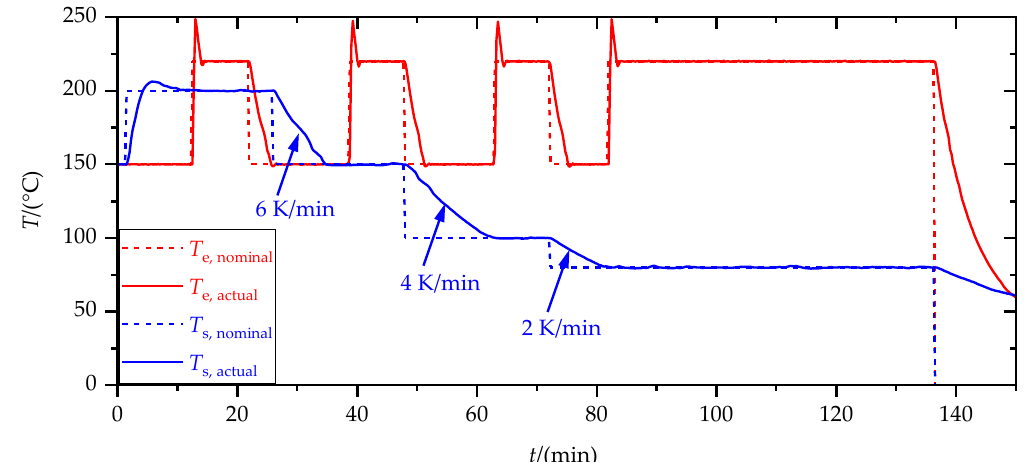
Figure 5. Temperature time profile of the nominal and actual temperature of the extruder, T e , and the substrate, T s , during production of an SLJ specimen. Cooling rates represent averaged values.